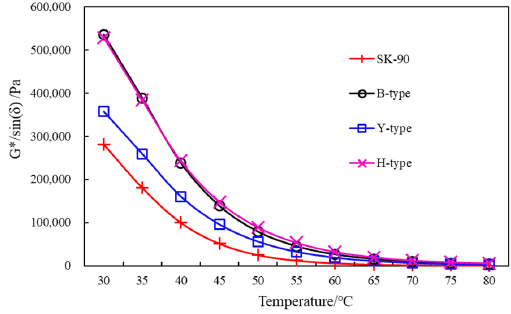
Figure 1. Ru tt ing factor evolution with temperature. Figure 1. Rutting factor evolution with